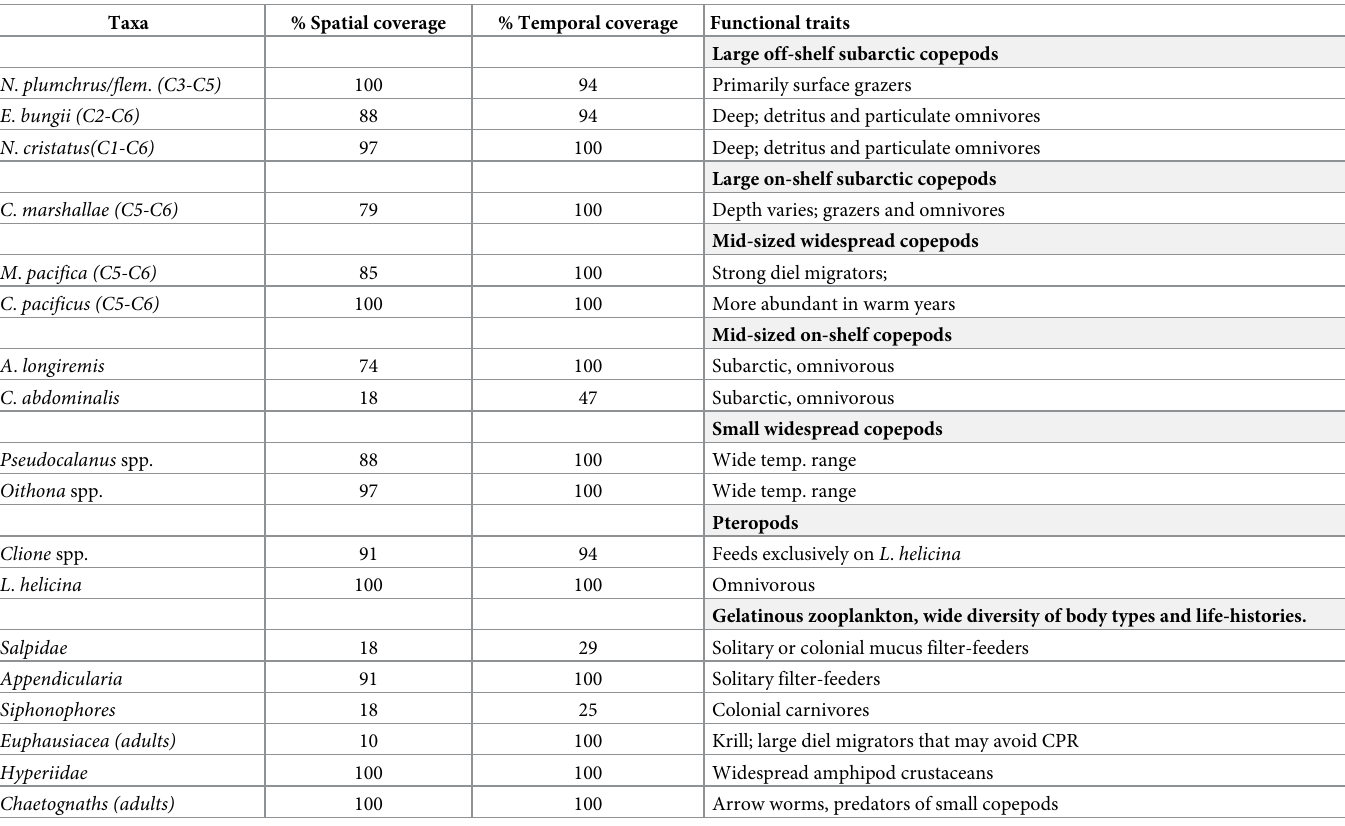
Table 1. The 20 dominant zooplankton taxa recorded in CPR transects, summarized by functional traits and frequency of abundance across 34 spatial bins and 17 years of data collection.